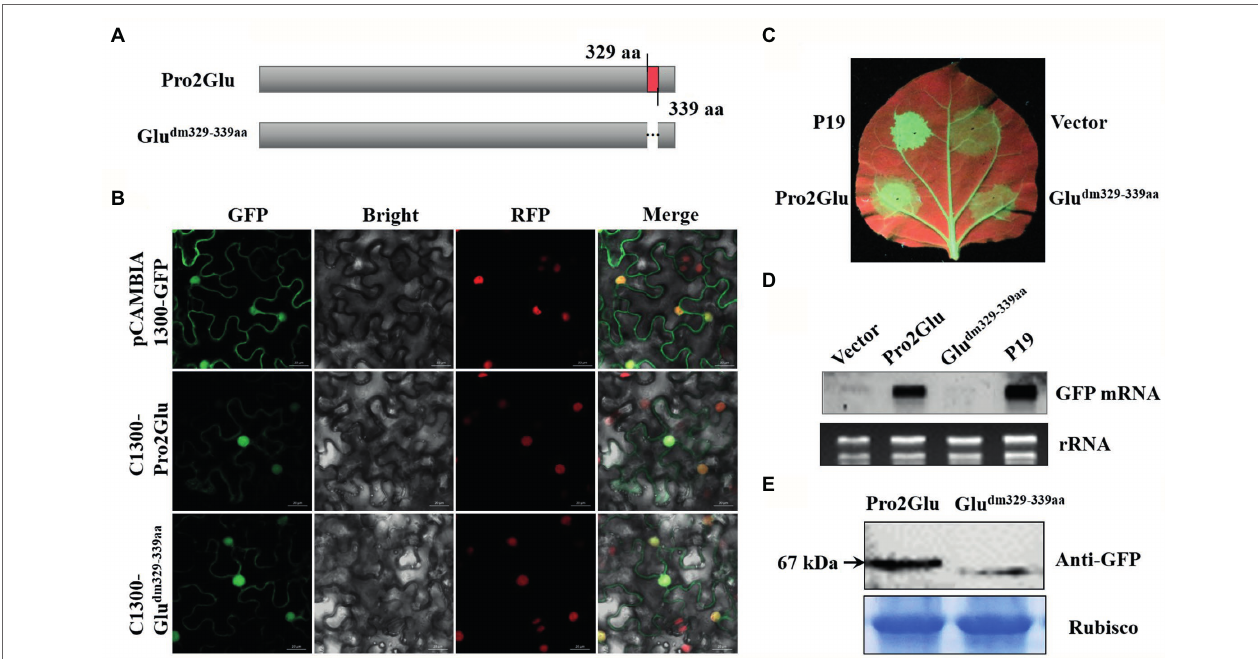
FIGURE 4 | The effect of deletion of 11 amino acids at the C-terminus of Pro2Glu on the subcellular localization and suppressor activity of Pro2Glu. (A) Schematic representation of Pro2Glu and its deletion mutant. (B) Subcellular localization of Pro2Glu and Glu dm329–339aa variant in leaf epidermal cells of red fluorescent protein transgenic N. benthamiana. Agrobacterium cultures containing pCAMBIA1300-GFP, C1300-Pro2Glu or C1300-Glu dm329–339aa was infiltrated into leaves of N. benthamiana , respectively. Imaging of fluorescent proteins was conducted using a confocal microscopy at 60 h post-infiltrated. (C) The observation of GFP fluorescence in leaves of N. benthamiana 16c infiltrated with a mixture of Agrobacterium cultures containing 35S-GFP and pCHF3-Pro2Glu (bottom left of leaf) or pCHF3-Glu dm329–339aa (bottom right of leaf) at 4 dpi. Expression of 35S-GFP with pCHF3-P19 (upper left of leaf) or pCHF3 vector (upper right of leaf) served as positive or negative controls, respectively. (D) The analysis of GFP mRNA in infiltrated leaf patches by Northern blot at 4 dpi. (E) Western blot analysis of total proteins from N. benthamiana leaf patches infiltrated with GFP-fused constructs C1300-Pro2Glu and C1300-Glu dm329–339 at 3 dpi using anti-GFP